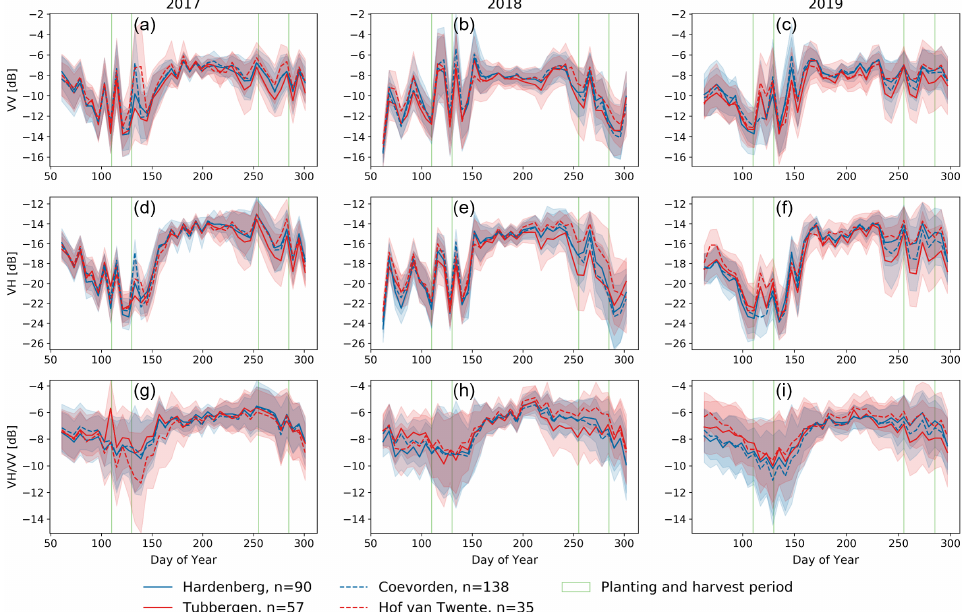
Figure 10. The 2017, 2018 and 2019 time series of Sentinel-1 SAR data (VV ( a – c ), VH ( d – f ) and VH/VV ( g – i )) from potato parcels in the Coevorden, Hardenberg, Tubbergen and Hof van Twente municipalities. The shaded areas indicate the standard deviation calculated across all parcels. Vertical green lines indicate crop sowing and harvesting